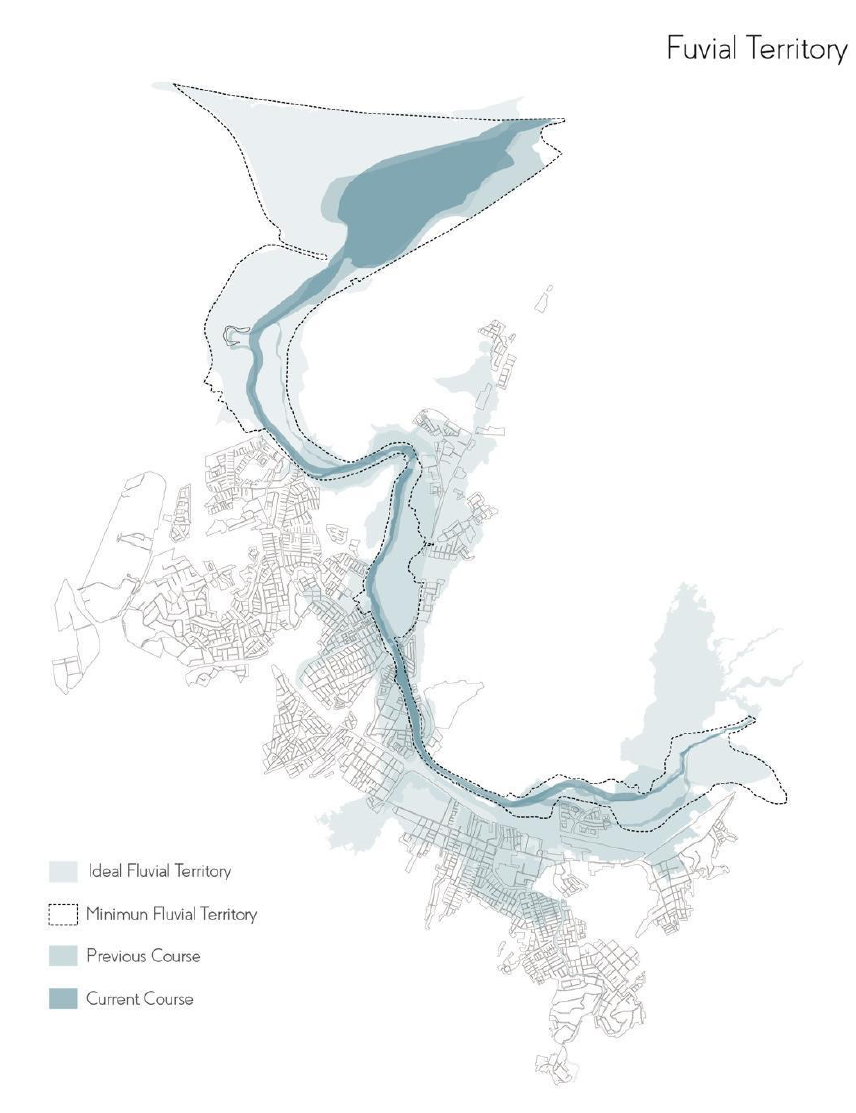
Figure 3. The minimum fluvial territory to keep a river alive. It is a hybrid area defined as a compromised area considering and ideal fluvial territory, historic or previous courses, the current course, and the urbanization. Source: By the author Espinosa, 2020 [52]. Table 1. Design questions proposed in the International Design Competition, Concepci ó n Living at (in) the Edge . Source: By the author Espinosa